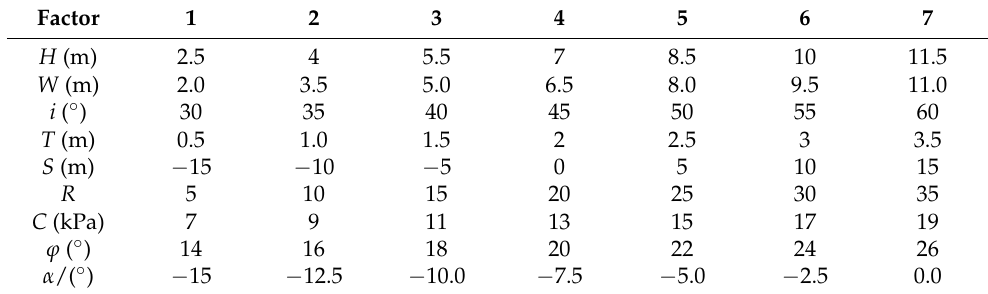
Table 8. Single-factor value